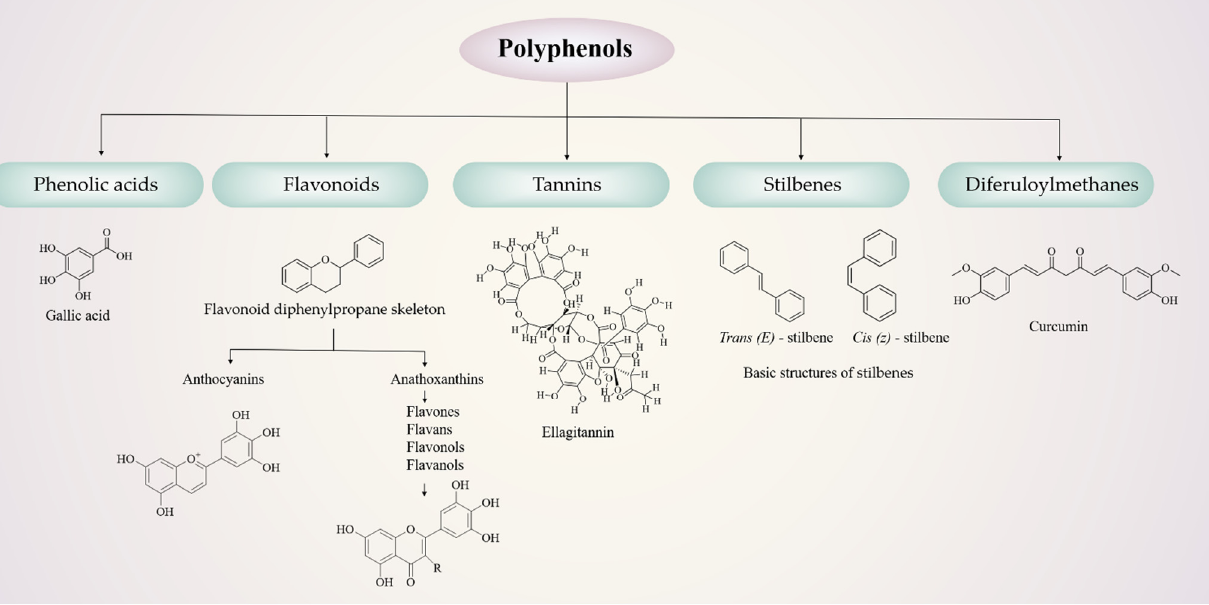
Figure 1. Classification of polyphenols.